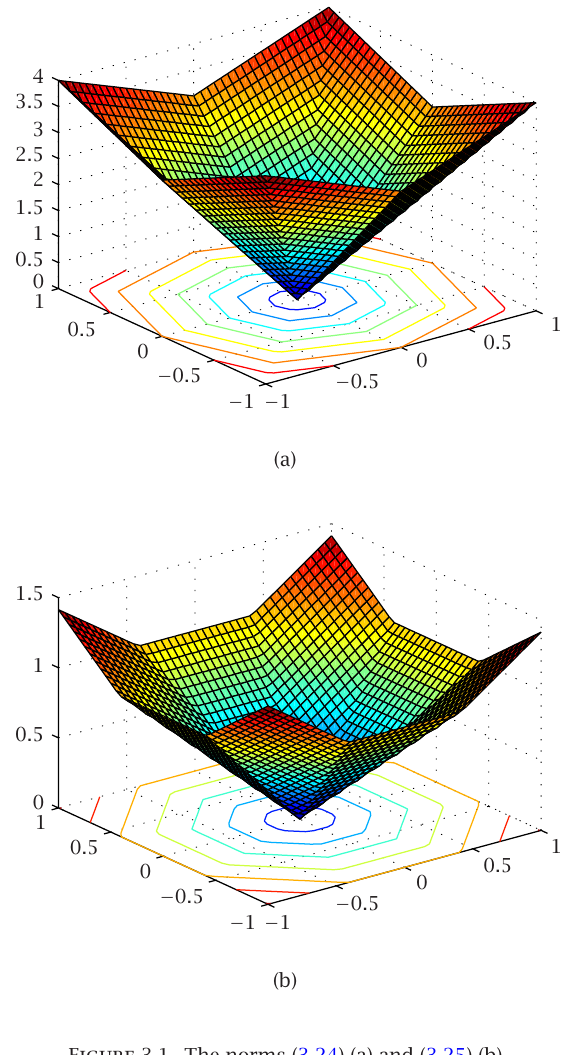
Figure 3.1 . The norms (3.24) (a) and (3.25)